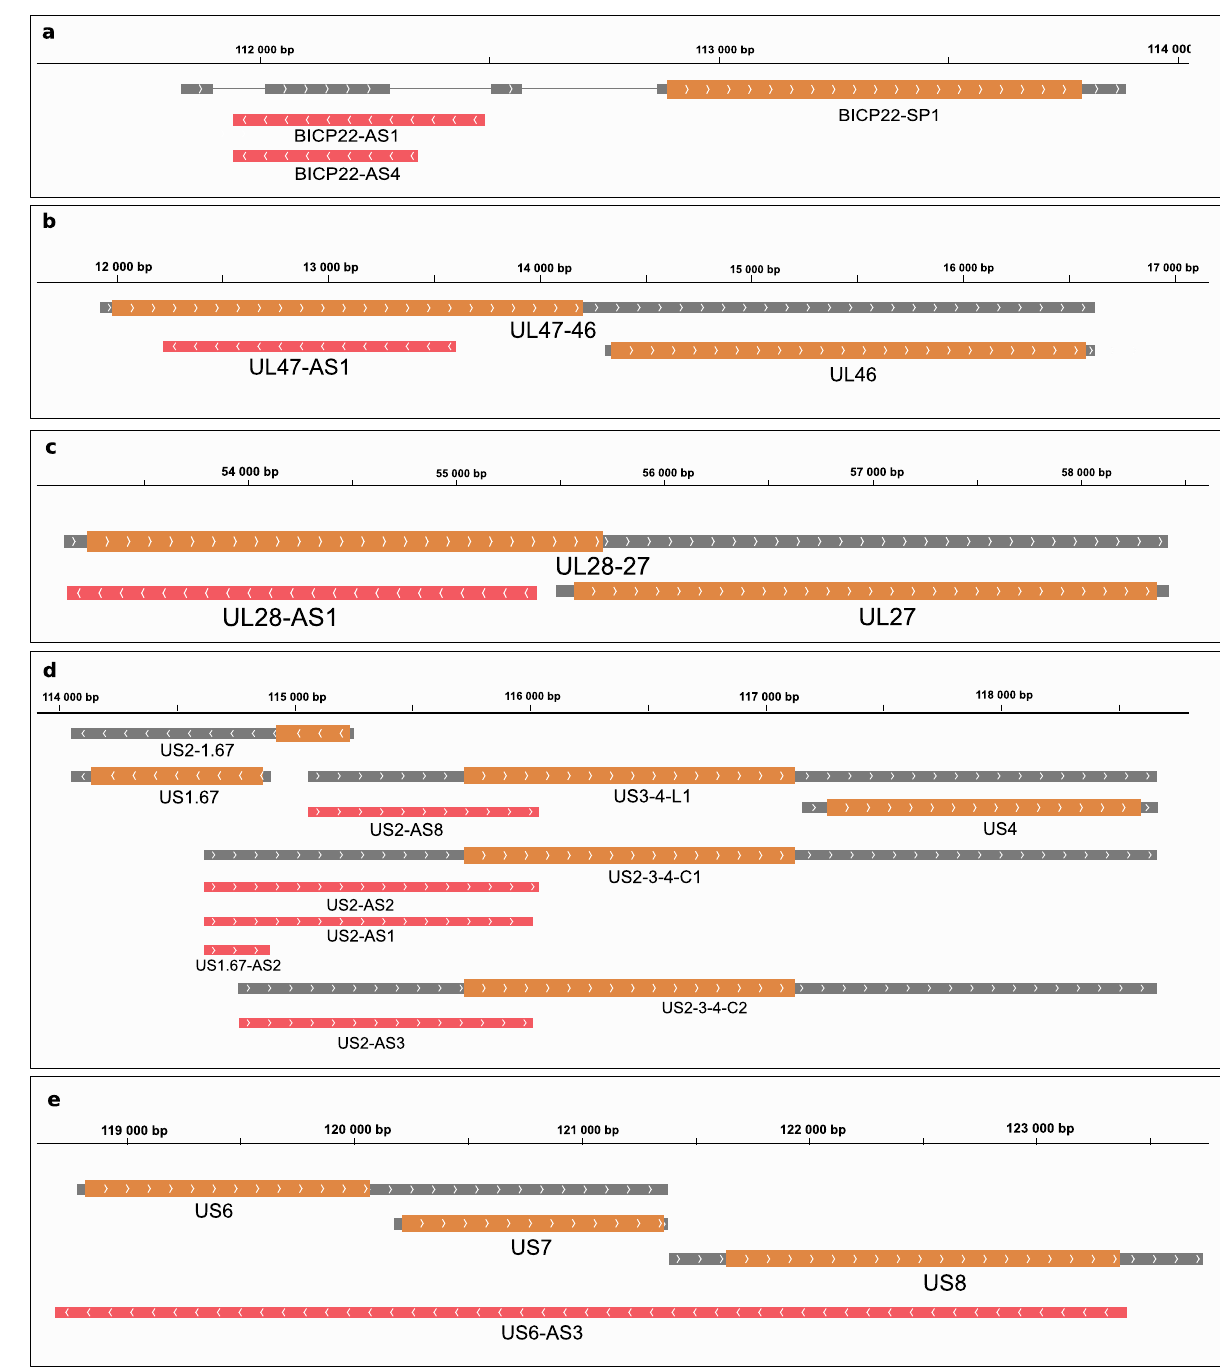
Figure 1. Antisense transcripts of the BoHV-1. Grey rectangles represent mRNAs. Wider overlapping orange rectangles are ORFs. Lines between rectangles represent introns. The orientation of transcripts is represented by arrow heads. Red rectangles represent antisense transcripts. ( a ) Two co-terminal antisense transcripts were detected overlapping the 5 ′ UTR of bICP22-SP1. ( b ) An antisense transcript overlaps the ORF of ul47. ( c ) One antisense transcript was detected overlapping the ul28 ORF. ( d ) Several antisense transcripts were detected overlapping us1.67 and us2. These start at the same TSS as the transcript isoforms of the adjacently located genes us3 and us4. ( e ) A very long antisense transcript overlaps the us6, us7 and us8